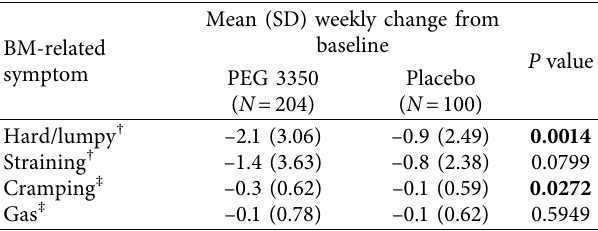
Figure 2: Mean weekly CSBMs (a) and SBMs (b) in subjects receiving PEG 3350 or placebo. †The change from baseline in the mean number of SBM and the mean number of CSBM each week was significantly greater with PEG 3350 versus placebo at week 1 ( P � 0 . 0040 and P � 0 . 0013, respectively) and highly significantly greater ( P < 0 . 0001 for both outcomes) each week for weeks 2 through 24. Abbreviations: CSBM, complete spontaneous bowel movement; PEG, polyethylene glycol; SBM, spontaneous bowel movement. Table 2: Change in BM-related symptoms per week over the 24- week study